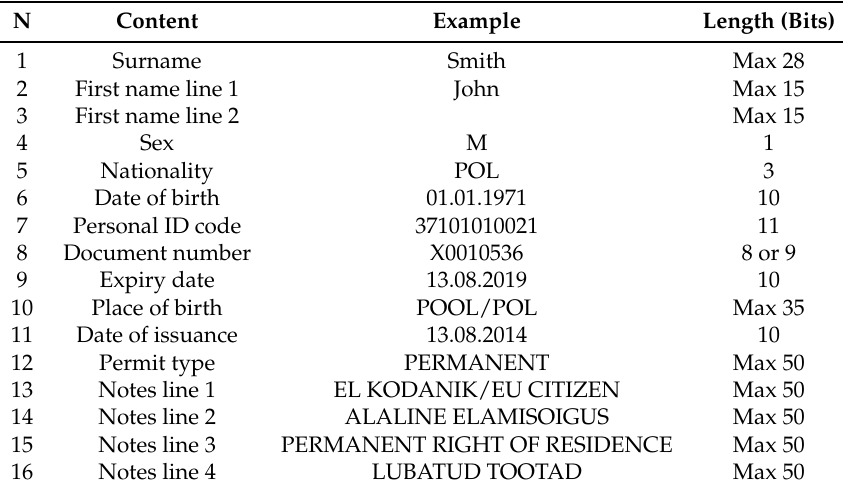
Table 1. Contents of a personal data file stored on an ID-card.